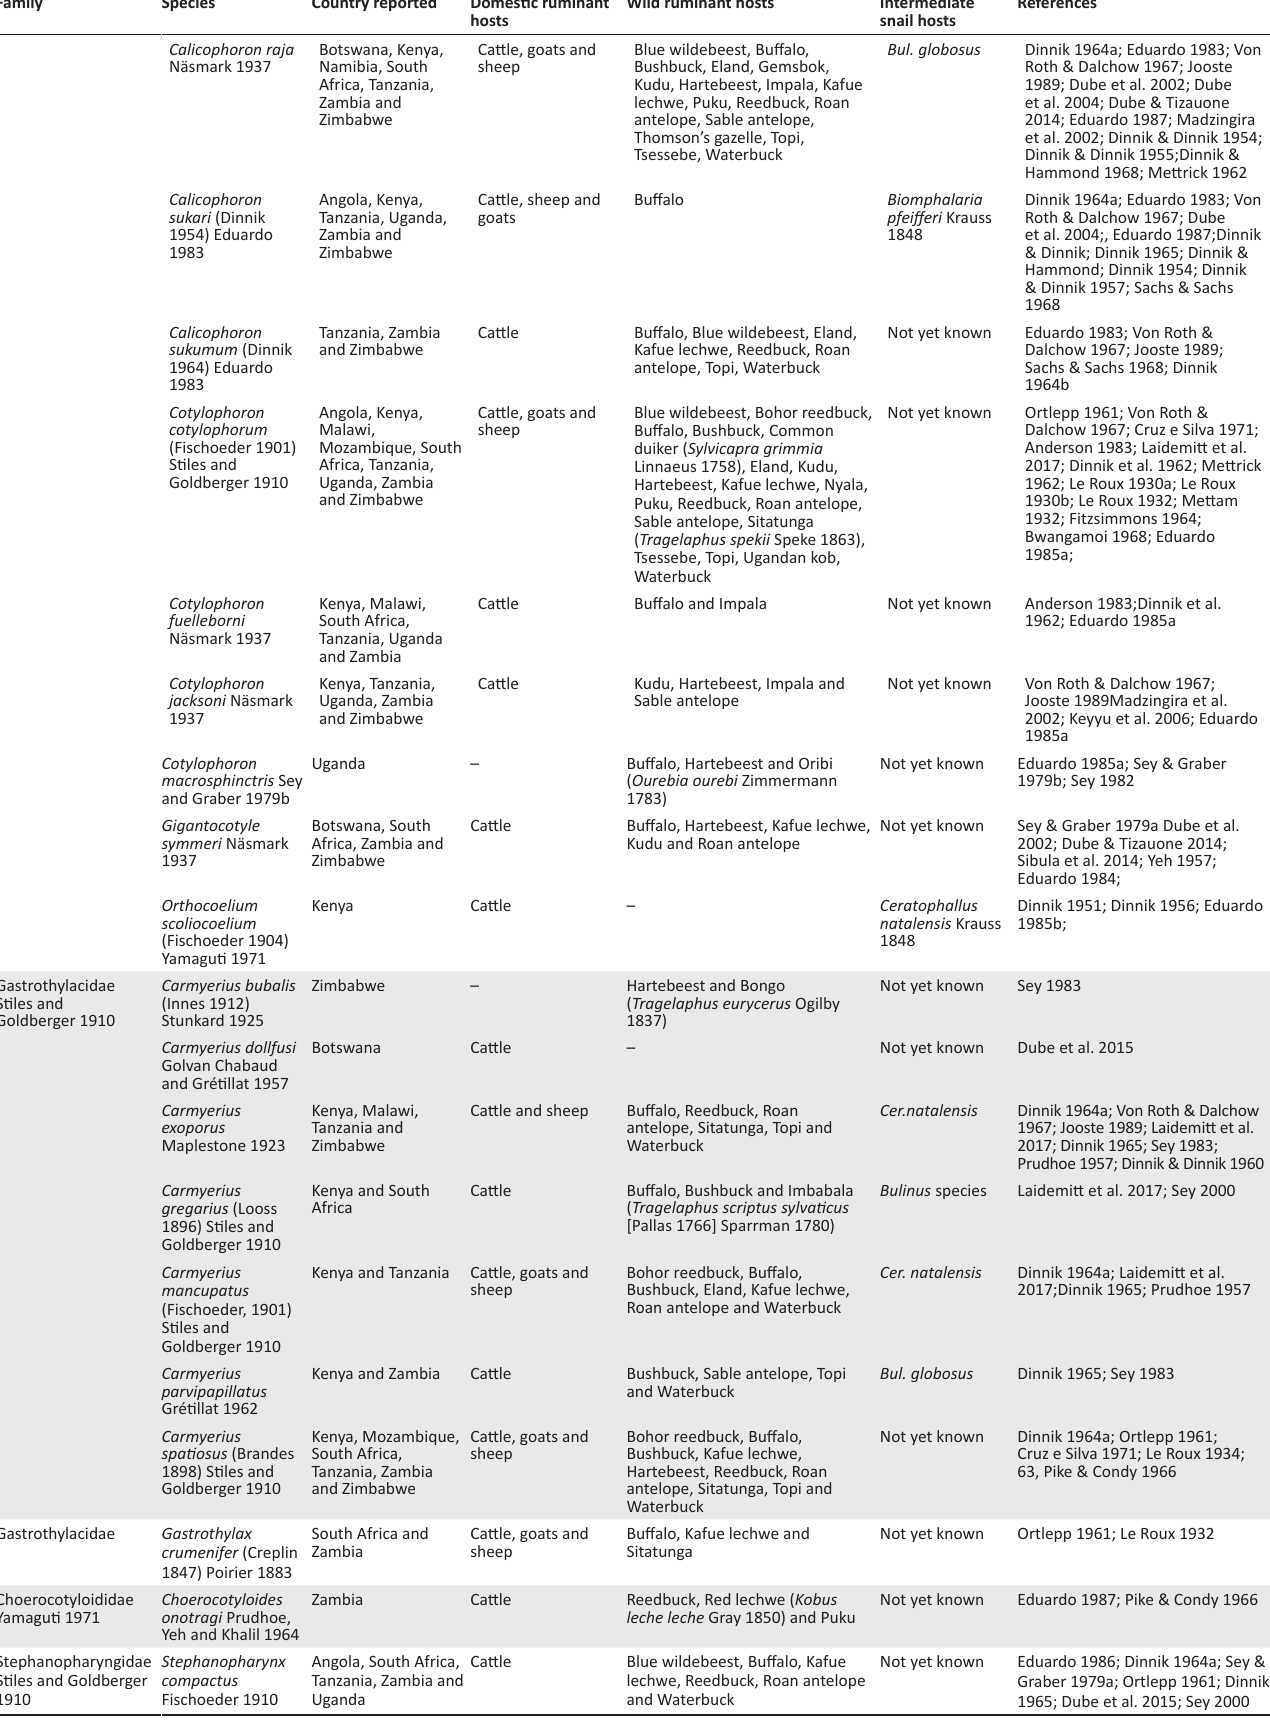
TABLE 1 (Continues...): Checklist of amphistome species and their ruminant and snail intermediate hosts reported in east and southern African